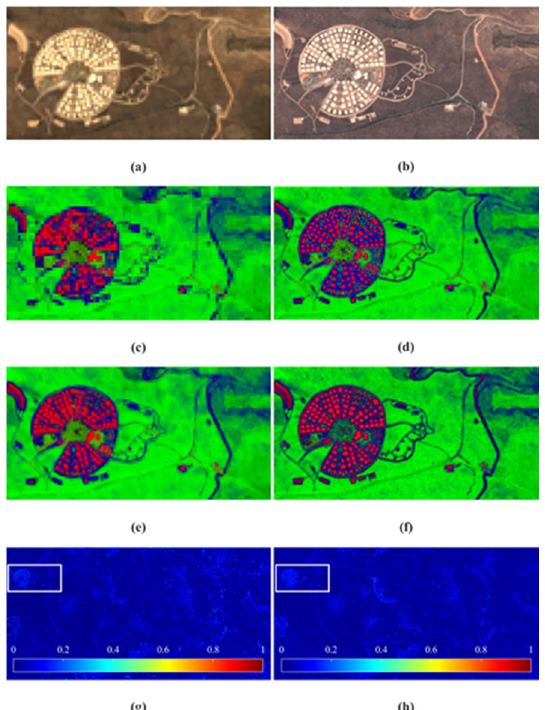
Figure 12. Zoom-in on the abundance fraction maps for three dominant EMs in the selected area for Test 1. ( a ) and ( b ) present RGB composites of the Landsat and Sentinel images, respectively. ( c ) and ( d ) present corresponding fraction maps, as obtained using the original spectral images with LSR 30 m and HSR 10 m (used as GT), respectively. ( e ) and ( f ) present corresponding fraction maps with HSR 10 m, as obtained using the image retrieved by the PSQ-PS method and as obtained by the proposed fusion method DFuSIAL, respectively. ( g ) and ( h ) present full mean absolute error (MAE) maps of the fractions obtained by the PS and DFuSIAL methods, respectively. The white rectangle in ( g ) and ( h ) marks the selected zoom-in area.